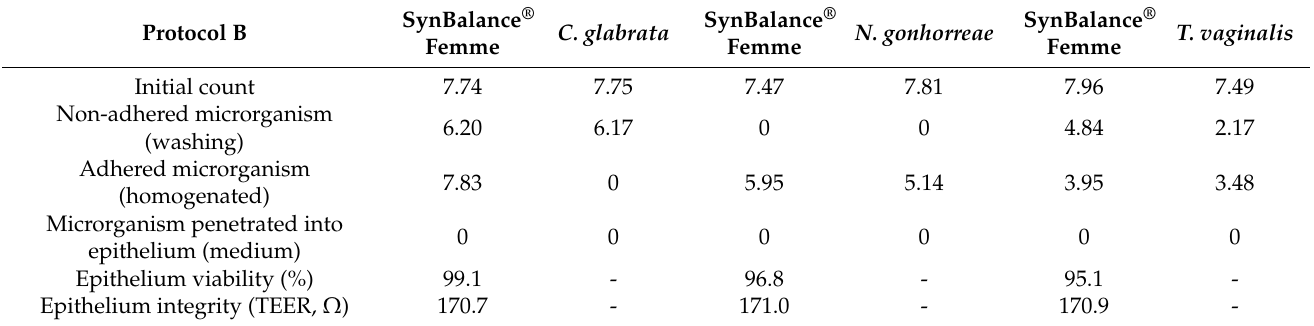
Table 2. In vitro model of preventive and antiadhesive efficacy of SynBalance ® Femme vs. C. glabrata ATCC 15126, N. gonhorreae ATCC 43069 or T. vaginalis ATCC 30238 on HVE. The amount of SynBalance ® Femme or each pathogen was expressed as log 10 CFU/mL. The epithelium viability